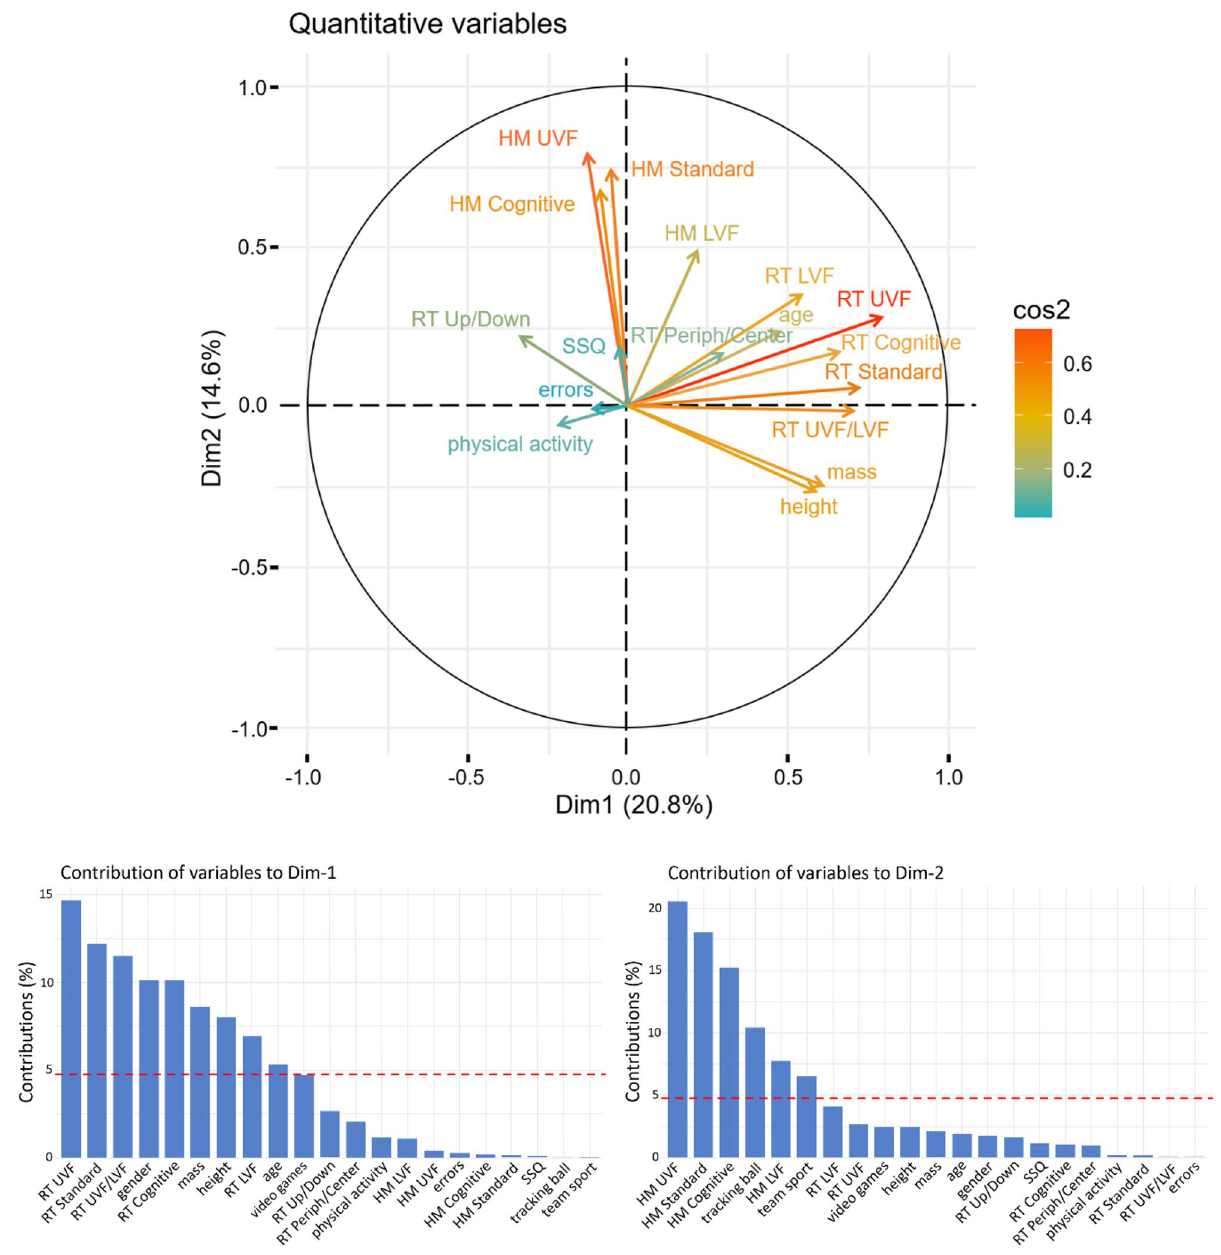
Figure 4. Upper panel: Principal Component Analysis of mixed data with the two main dimensions projected on orthogonal axes. RT performances in each mode actually represent mean test–retest 1/RT so that a high value indicates a great performance (quick response). HMs cues represent the mean test–retest 95% confidence ellipse of head movements in each mode. Physical Activity represents one’s weekly hours of practice. Errors indicates the number of one’s false verbally reported digits displayed during Cognitive condition. RT Periph/ Center and RT Up/Down represent performances in the peripheral vs. (any of the) inner circles and upper- vs. lower-hemisphere hits recorded in Standard + Cognitive. Only quantitative variables are represented. Higher values for each variables are positively scattered along the components axis. Lower panels: contribution of each variable to the first two dimensions of the PCAmix illustrated by orthogonal axes. The dotted line corresponds to the expected value if the contribution of each variable was uniform. Contributions for qualitative variables represents ‘male’ over ‘female’ for gender, ‘yes’ over ‘no’ for video-game practice, and ‘no’ over ‘yes’ for team sports and tracking ball sports